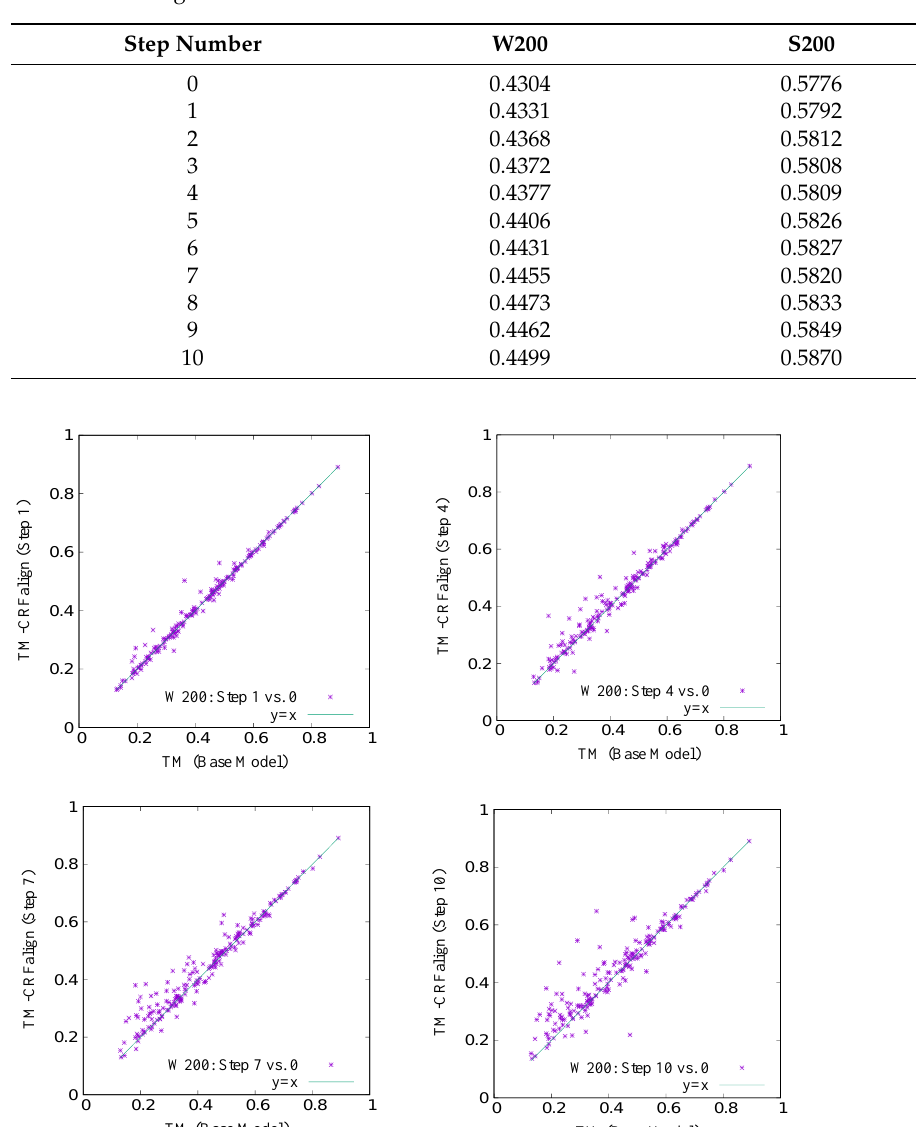
Table 3. Modeling accuracies in average TM score of the test sets W200 and S200 based on the five-state training with TR367 set.